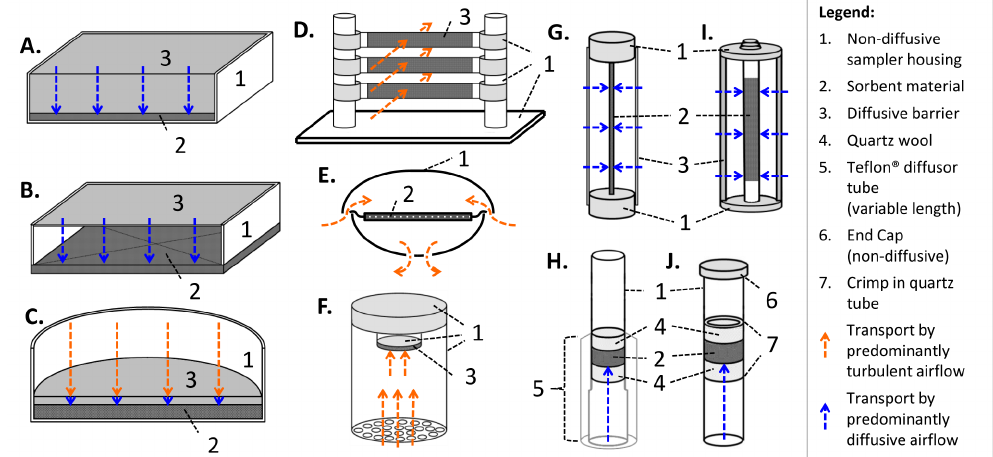
Figure 2. Schematics of existing PASs for GEM. Sampler A: box-type axial-diffusion-type PAS tested by McCammon and Woodfin (1977). Sampler B: box-type axial-diffusion-type PAS by Mattoli et al. (2007). Sampler C: badge-type axial-diffusion-type PAS by Mniszek (2001). Sampler D: PAS by Brumbaugh et al. (2000) containing liquid sorbent inside lay-flat low-density polyethylene tubing. Sampler E: